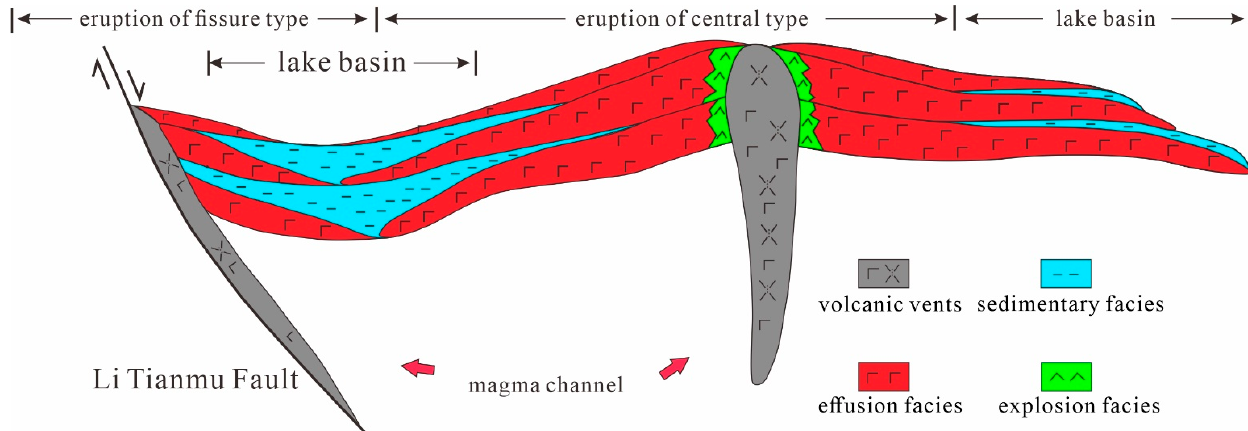
Figure 7. The volcanic development pattern of the Zao35 fault block.